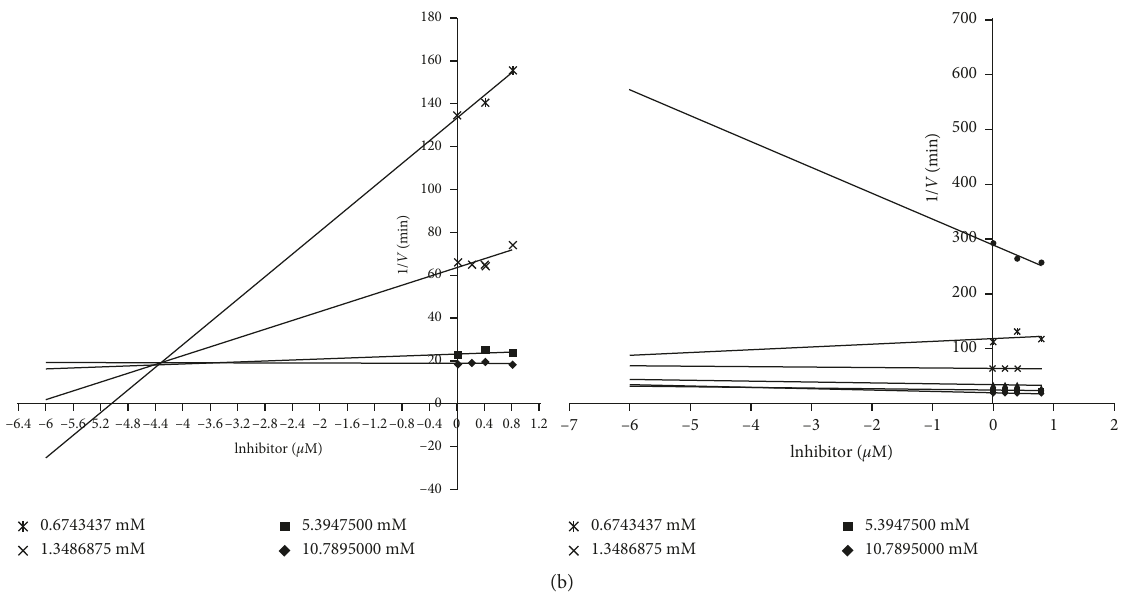
Figure 7: Dixon plots showing the inhibitory effects of the DNJ transglycosylation product on α -glucosidase (a) and α -amylase (b) activity. The reaction rate of the enzyme was measured in the presence of DNJ (left) and G1-DNJ (right). Table 2: Kinetic study of enzyme inhibition by DNJ and G1-DNJ.